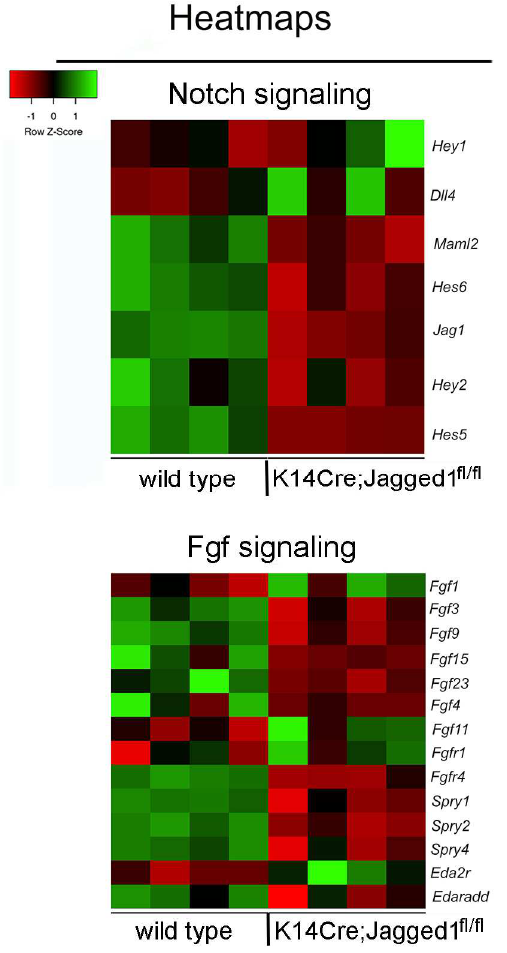
Figure 3. Heatmaps showing the main deregulated genes involved in the Notch and FGF signal- ing pathways in K14Cre;Jagged1 fl/fl molars.